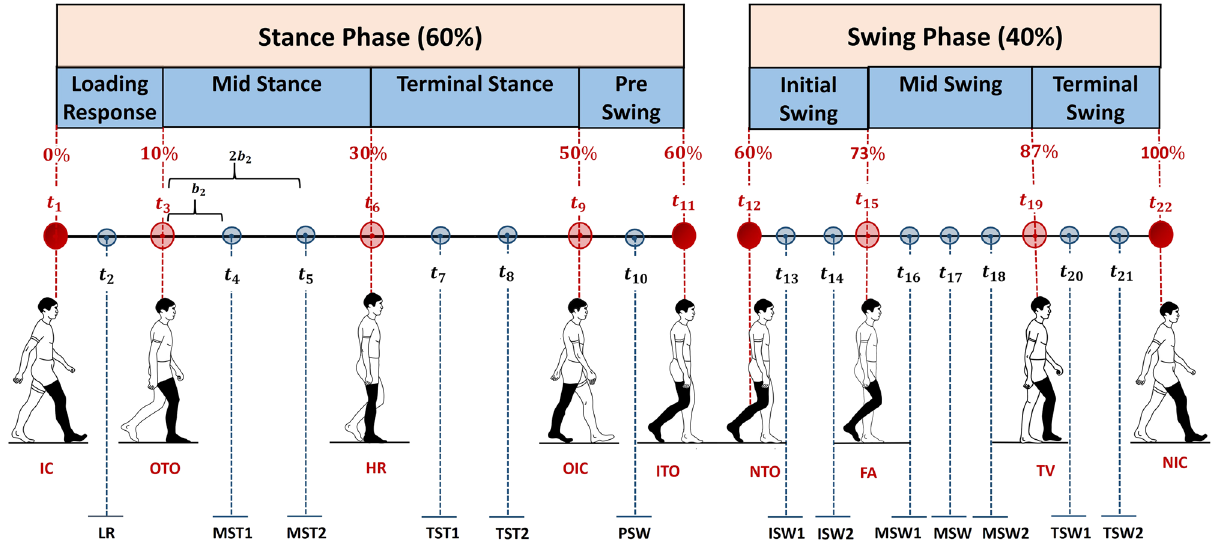
Figure 6. Gait event occurrence indexes used in the GI feature selection process. 22 gait events are used in the feature selection process. Each index is labelled based on its event number (e.g. t 1 for event 1 and t 22 for event 22). Gait indexes of main events are marked in red (bigger) circles, where the IC, ITO, NTO, and NIC indexes extracted from Visual3D (C-motion Inc., Kingston, Canada) automatic event detection algorithm are marked in red (bold) circles. The gait indexes of intermediate events are marked in blue (small) circles. The pre-defined gait indexes are indicated in percentages of the gait cycle. Each intermediate event indexes are calculated by shifting the starting gait index of the sub-phase by a step size b (see Eq. 1). The number of steps taken to locate the index of each intermediate event is a multiple of the intermediate event number of the sub-phase. For example, this figure illustrated the step size ( b 2 ) taken in extracting indexes within 2nd sub-phase (Mid Stance). The index ( t 4 ) correspond to the first intermediate event of 2nd sub-phase was extracted by taking a step size of b 2 × 1 , whereas the index t 5 corresponding to the 2nd intermediate event was extracted by taking a step size of b 2 × 2